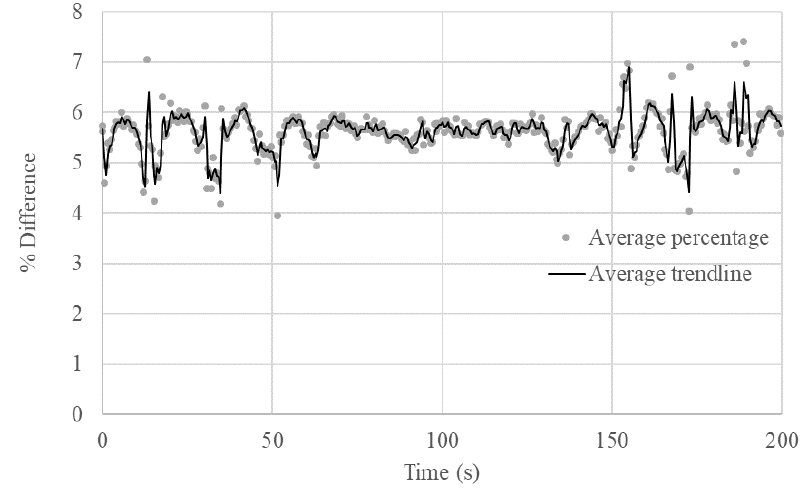
Figure 25. Averaged percentage difference between soil conventional methods.